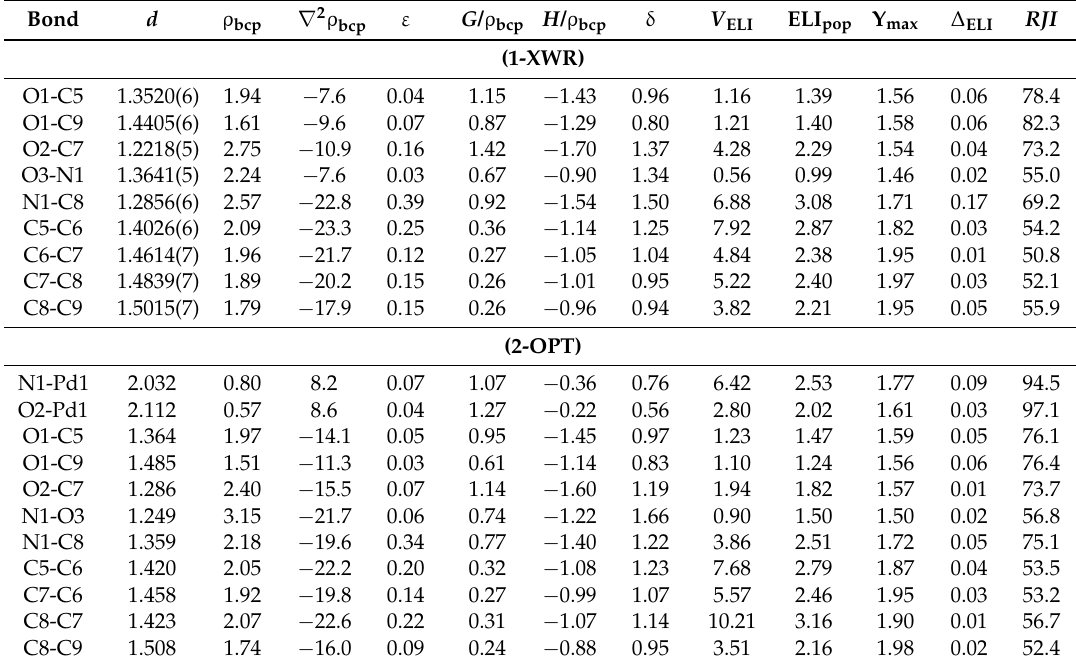
Table 3. Geometrical a , topological b and integrated c bond descriptors determined for selected bonds in XWR-model of 1 and OPT-model of 2 d